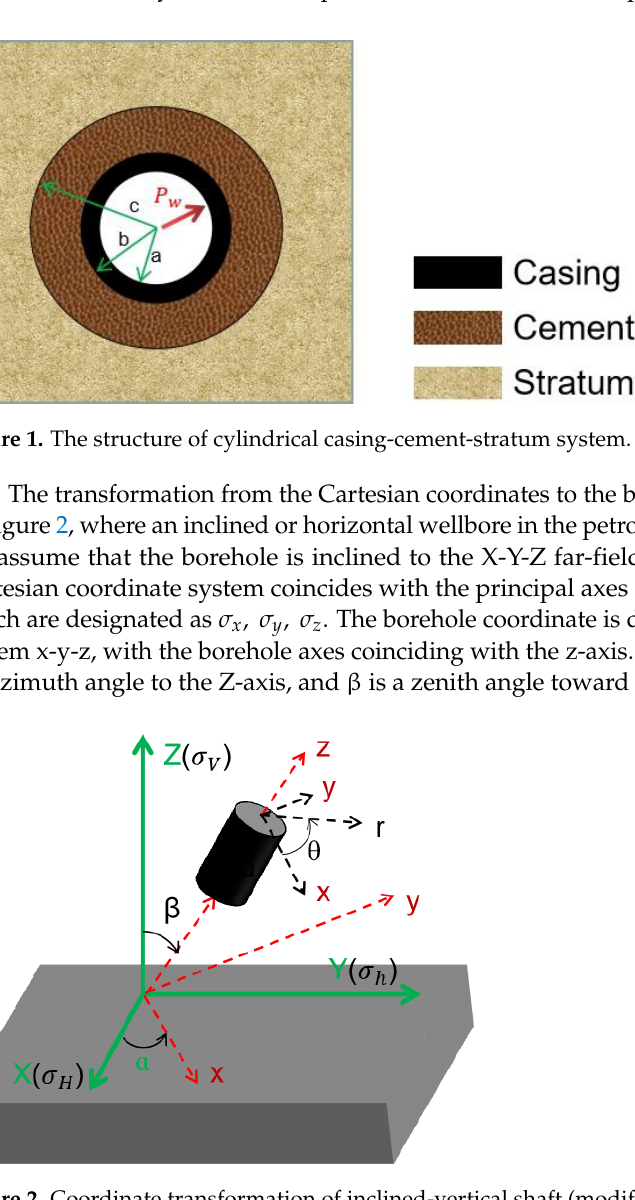
Figure 2. Coordinate transformation of inclined-vertical shaft (modified from Gao et al. [33]).